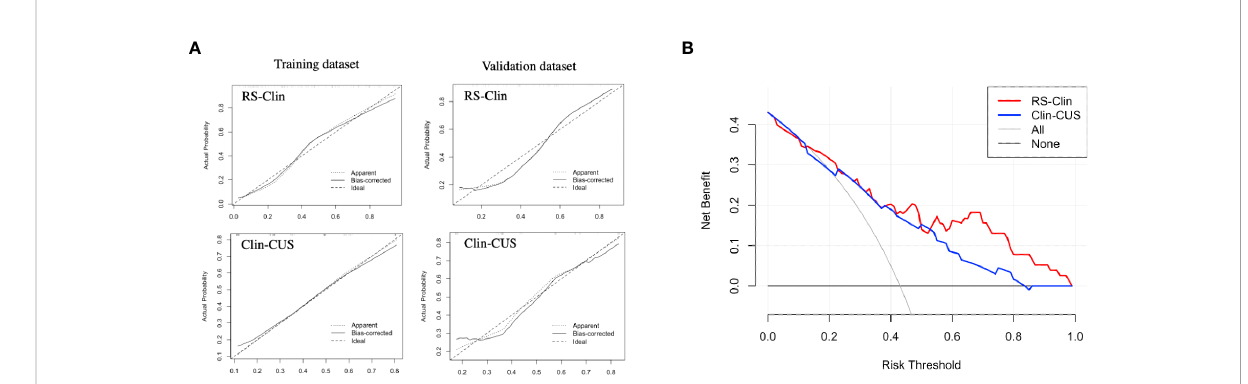
FIGURE 6 (A) Calibration curve of RS-Clin and Clin-CUS model for predicting the probability of CLNM in the training dataset and validation dataset. (B) Decision curve analysis of two nomogram models for predicting the probability of CLNM in the validation dataset. RS-Clin, radiomics scores + Clinical features; Clin-CUS, Clinical features + CUS features; CLNM, central lymph node